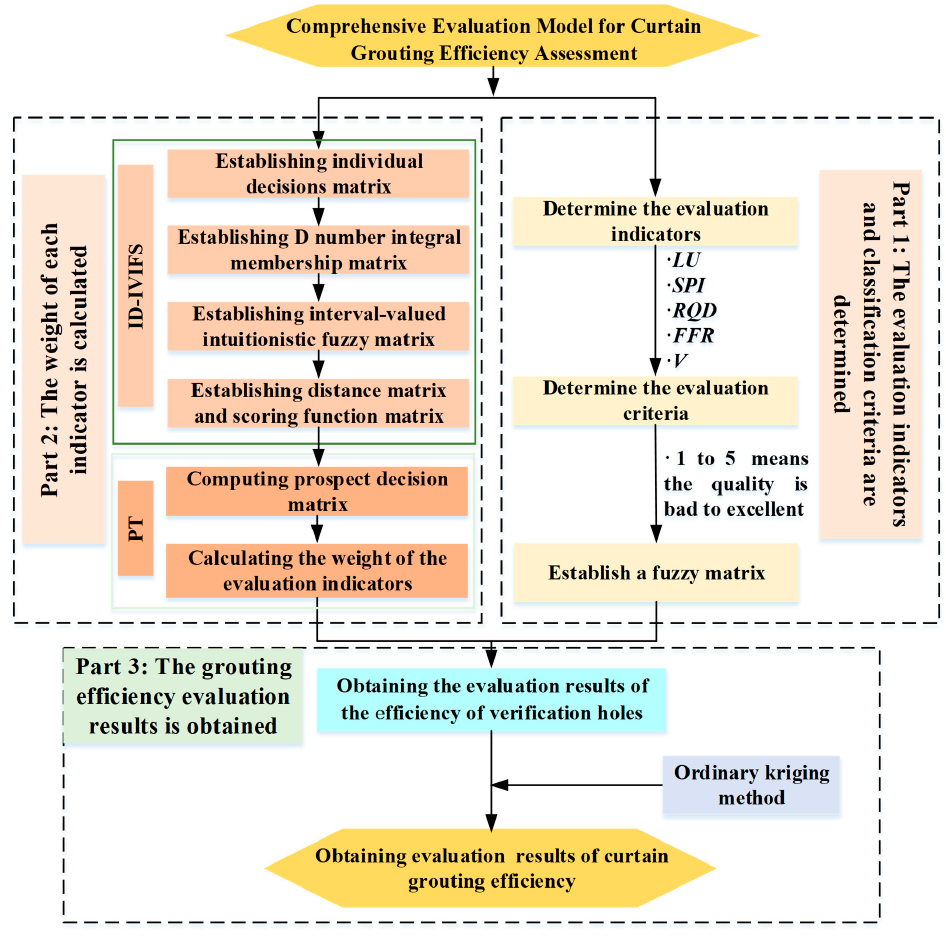
Figure 4. Solution process of the grouting-efficiency comprehensive evaluation model.